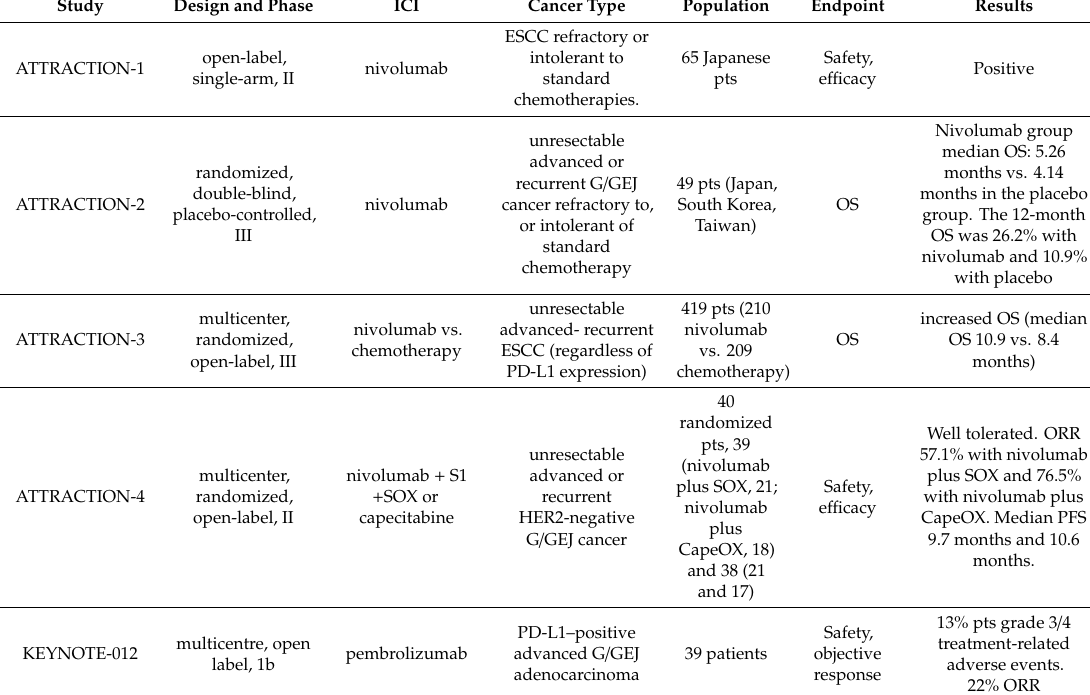
Table 4. Main clinical trials evaluating ICI in upper GI cancers